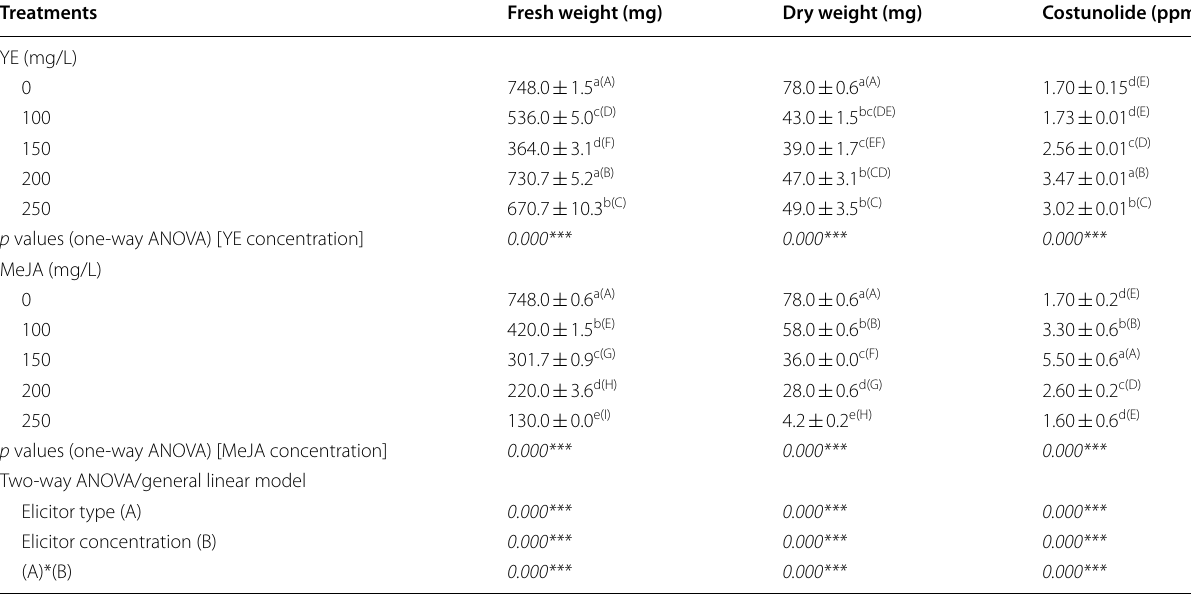
Means ( n 30) standard error (S.E.) with the same letter in a column are not statistically significant different from each other according to the Duncan’s multiple = ± range test at